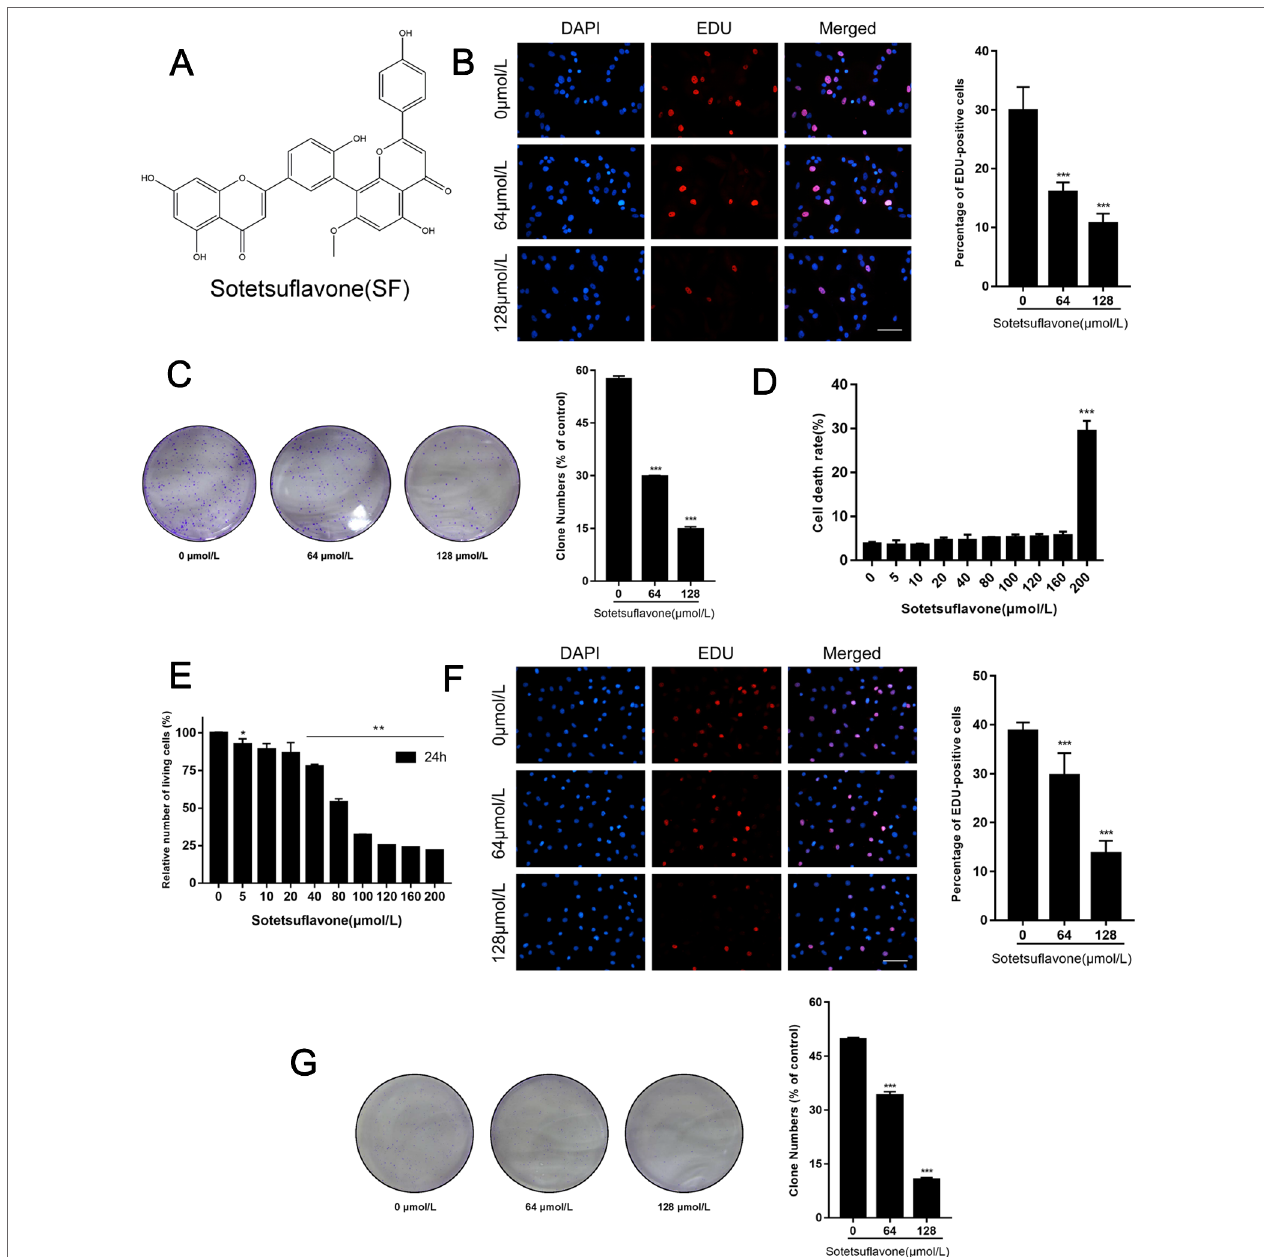
FIgURe 1 | Sotetsuflavone inhibits proliferation of non-small cell lung cancer cells. (A) The chemical structure of sotetsuflavone with a molecular weight of 552.491 g/mol. Sotetsuflavone is a biflavonoid which is formed by aapegenin linked by the 8th position of the A ring to the 3′ position of the 7-methylapigenin B ring. (B) Proliferating A549 cells were labeled with EDU (red), cell nuclei were stained with DAPI (blue), and the percentage of EDU-positive A549 cells was quantified. Original magnification, ×200. (** p < 0.001 vs. control). (C) Results from A549 cell colony formation assays (*** p < 0.001 vs. control). (D) The toxicity of sotetsuflavone on normal lung epithelial cells (BEAS-2B) was detected by use of trypan blue staining. Living cell rate = total number of living cells/(total number of living cells + total number of dead cells) × 100% (*** p < 0.001 vs. control). (e) The relative number of H1650 living cells treated with different concentrations of sotetsuflavone for 24 h (* p < 0.05, ** p < 0.01 vs. control). (F) Proliferating H1650 cells were labeled with EDU (red), cell nuclei were stained with DAPI (blue), and the percentage of EDU-positive H1650 cells was quantified. Original magnification, ×200 (*** p < 0.001 vs. control). (g) Colony formation assays were also performed to measure the growth of H1650 cells (*** p < 0.001 vs.